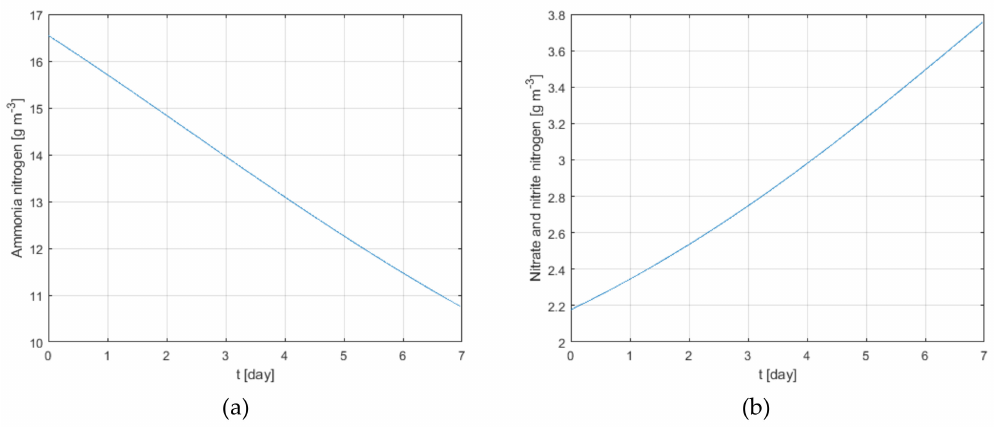
Figure 6. Ammonia nitrogen ( a ) and nitrate and nitrite nitrogen ( b ) in the first aeration